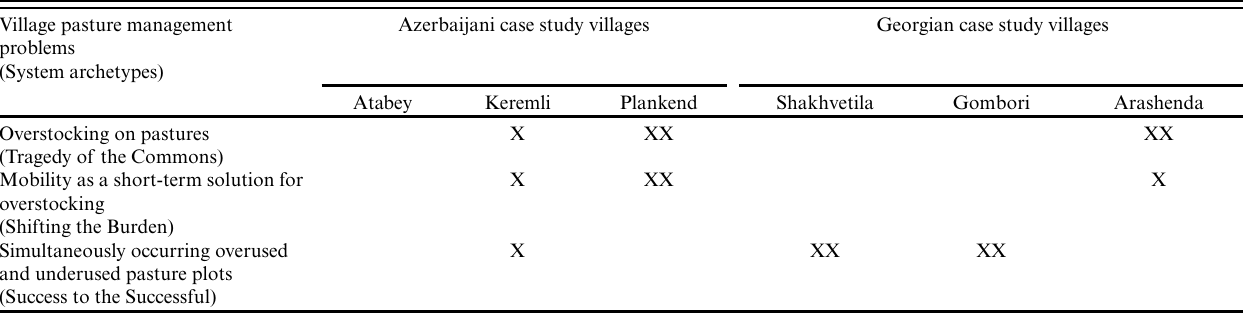
Table 7 . Occurrence of village pasture management problem archetypes in the case study villages. Village pasture management